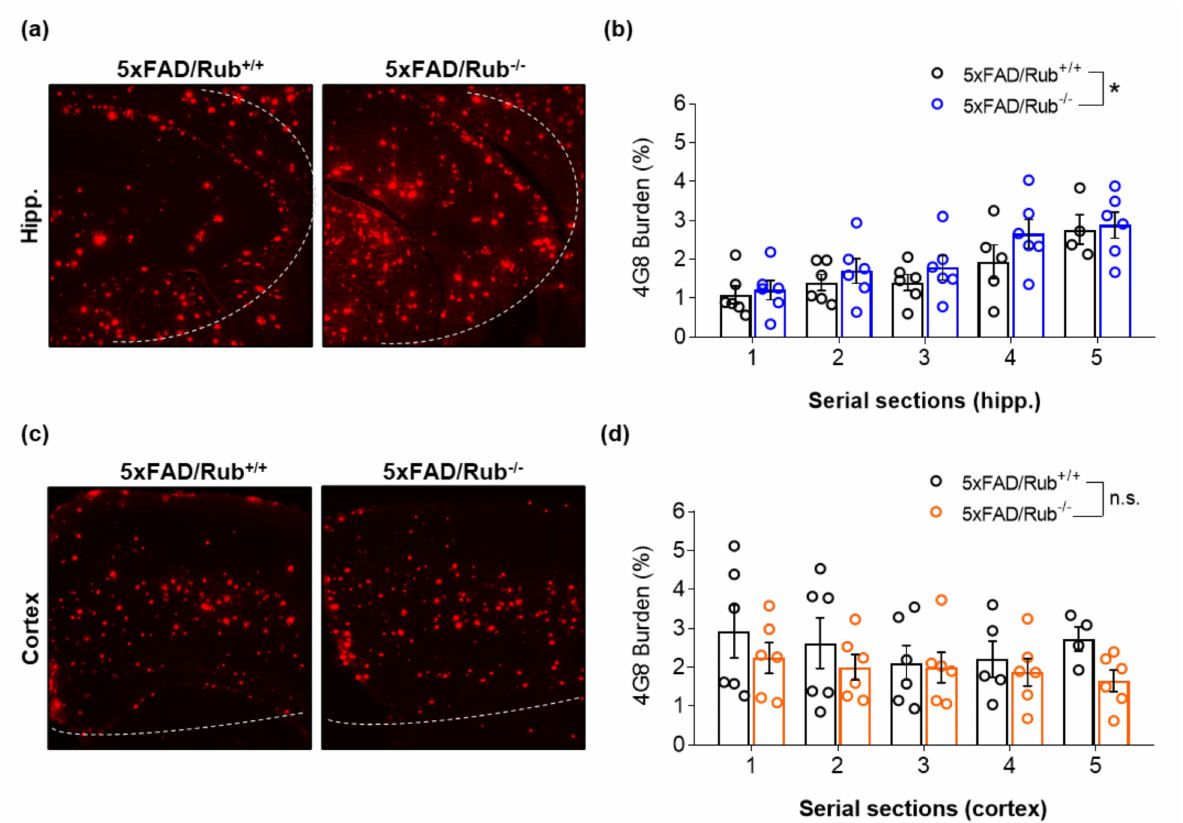
Figure 4. Amyloid β burden is increased in hippocampus sections from 5xFAD-lacking Rubicon mice at the symptomatic stage but not in the cortex. ( a ) Representative Z-stack of immunocytochemical confocal images of amyloid β plaque detection (4G8, red) in the hippocampus and cortex ( c ) of 5xFAD mice with regular expression of Rubicon (5xFAD/Rub+/+) on the left and mice lacking Rubicon (5xFAD/Rub − / − ). Images are representative of at least four animals for each genotype. ( b , d ) Quantification of the intensity of fluorescence of 4G8 burden in serial sections of the hippocam- pus ( c ) (from ( a )) and cortex ( d ) (from ( b )). Data are mean ± SEM. * p < 0.05 as determined by repeated-measures ANOVA, n.s., no